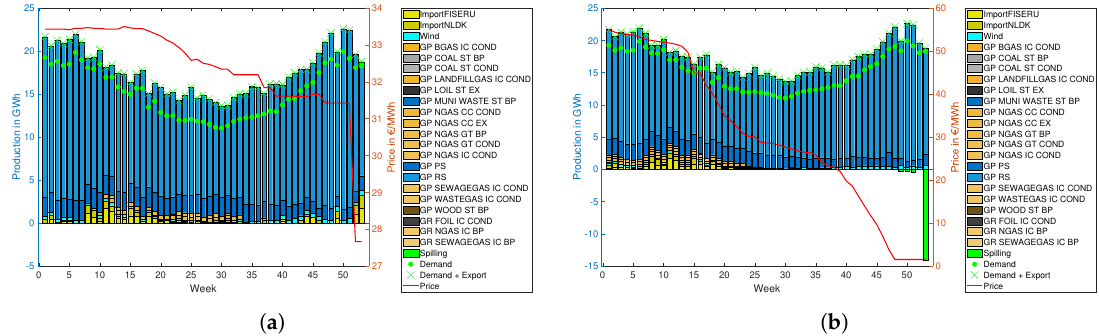
Figure 6. Impact of the expectation of less water inflow than the one that materializes. ( a ) production for model run EM 3_ L ; ( b ) production for model run EM 13_ L